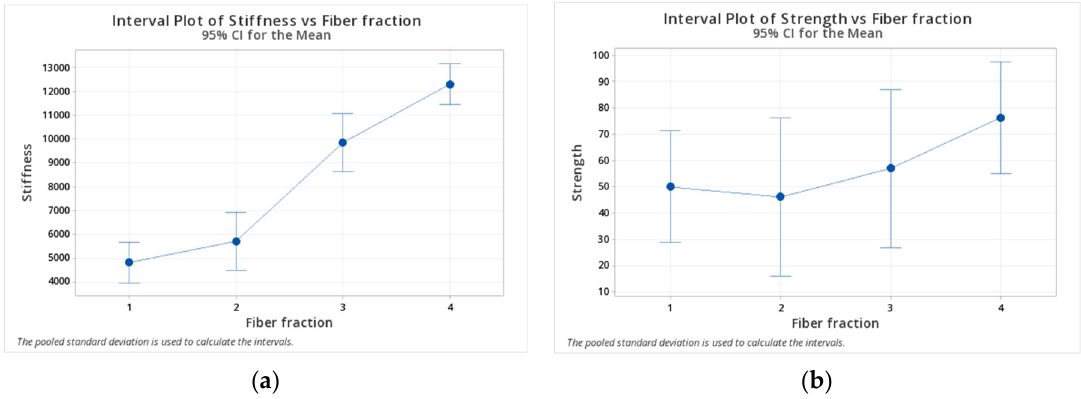
Figure 5. Interval graphs for ( a ) stiffness and ( b ) strength of on ‐ edge specimens.